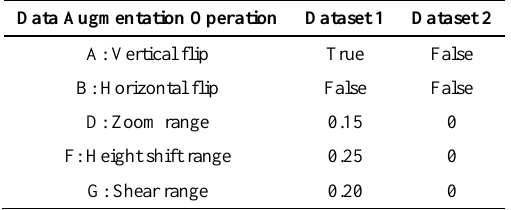
Table 8. Optimal Configuration of Data Augmentation Operations on